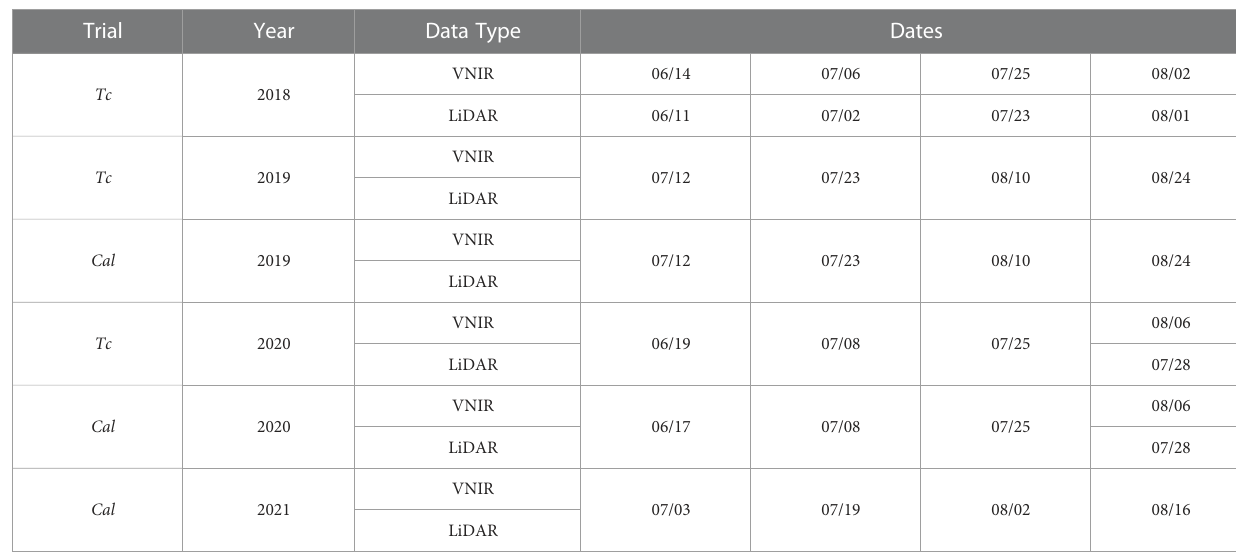
TABLE 2 Remote sensing data sets used in this